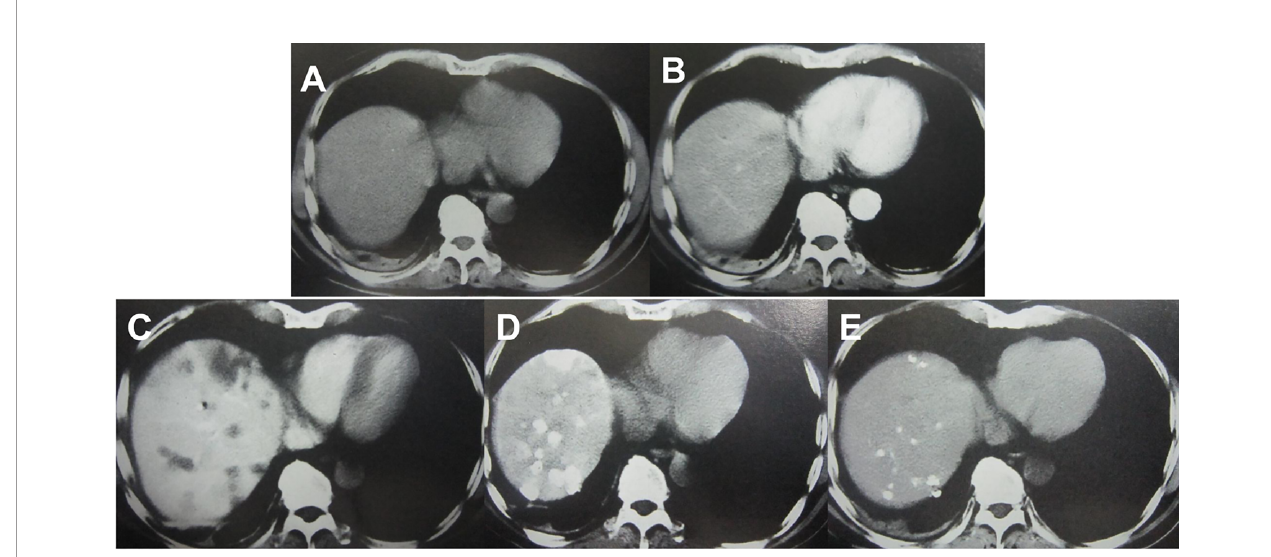
FIGURE 3 | Imaging examination of an HCC patient with a progressively elevated AFP level. (A) CT plain scan showed no lesions in the liver; (B) A contrast- enhanced CT scan failed to reveal any lesions in the liver; (C) CTAP showed intrahepatic low-density lesions; (D) CTHA showed intrahepatic high-density lesions; (E) Lp-CT showed multiple intrahepatic lipiodol deposits after 3